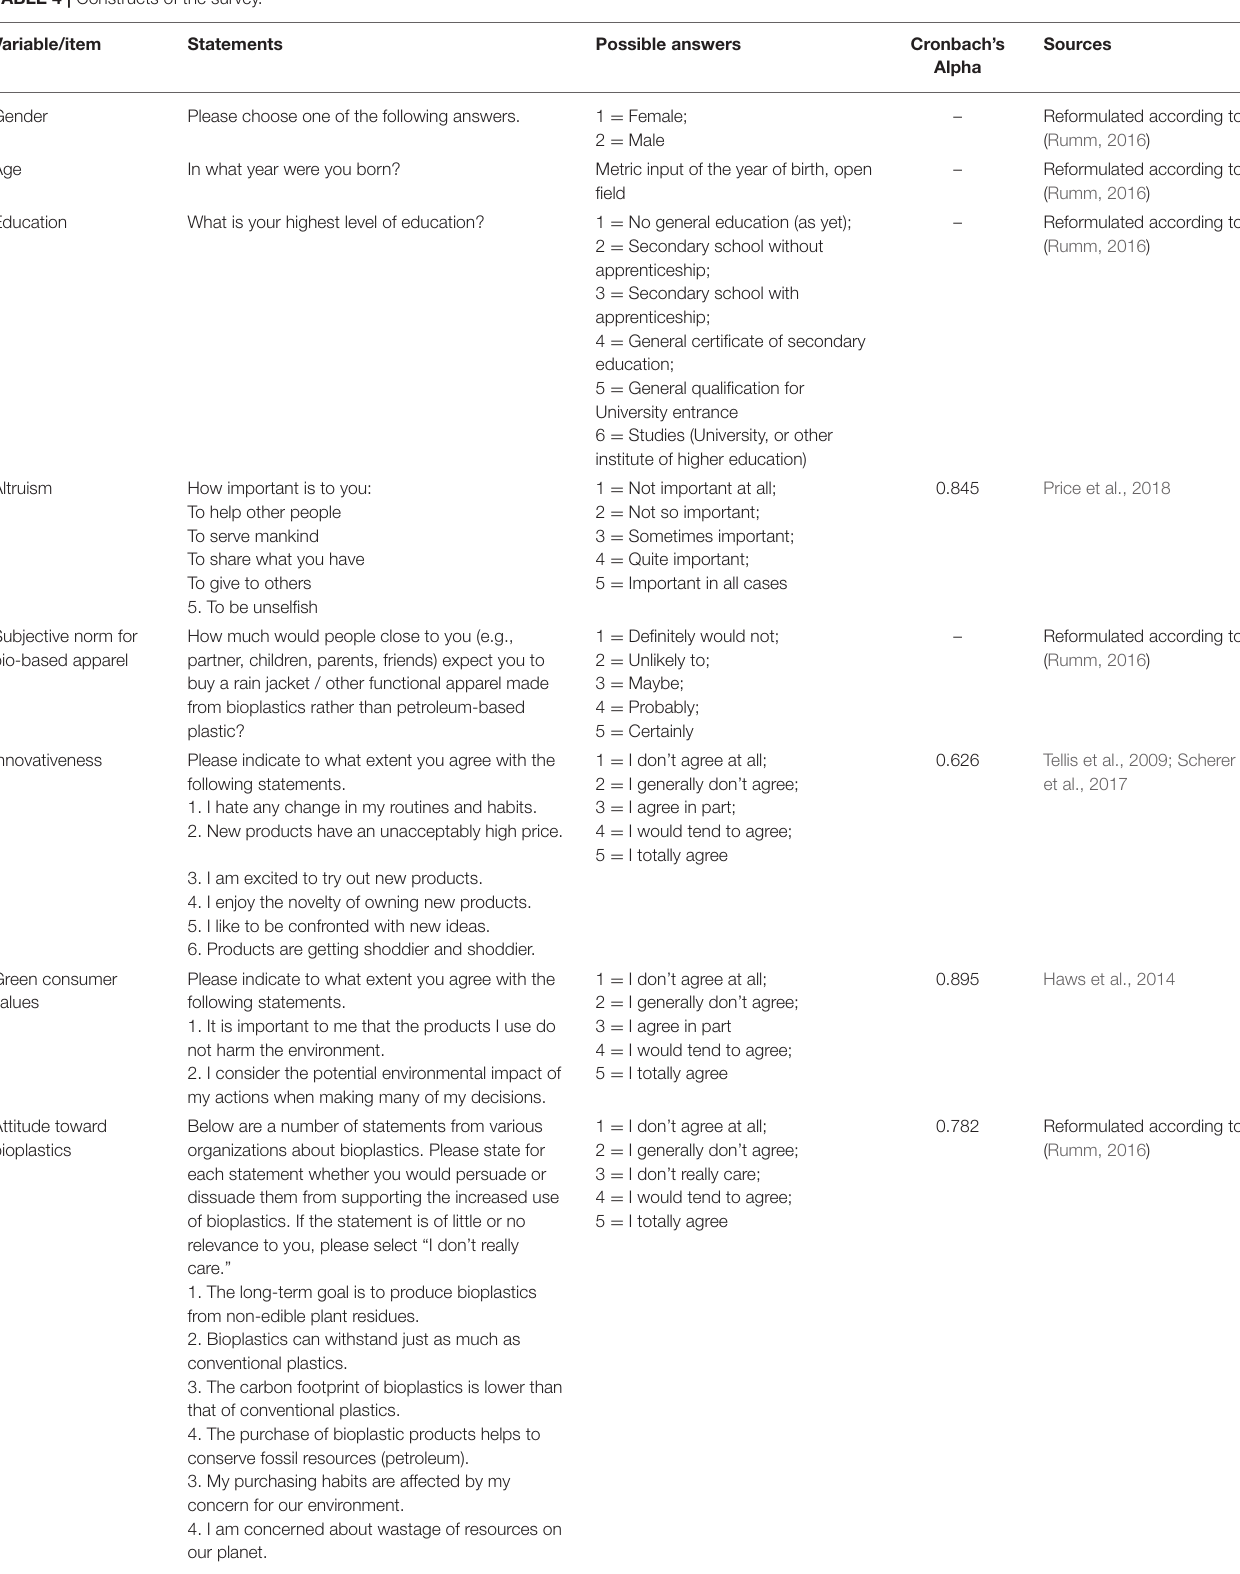
TABLE 4 | Constructs of the